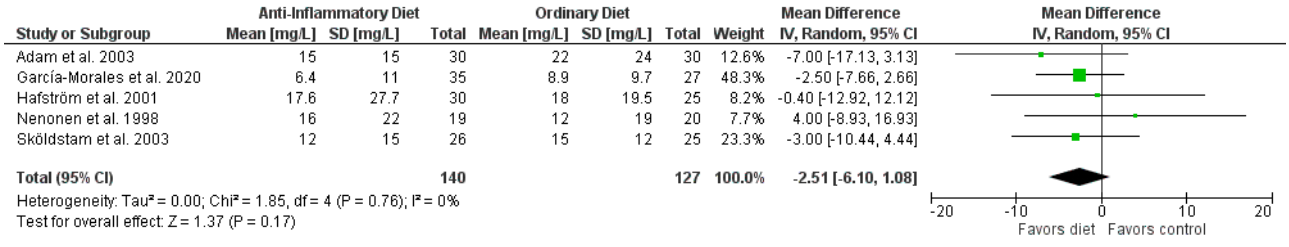
Figure 3. Forest plot summarizing the effect of anti-inflammatory diets on C-reactive protein levels.